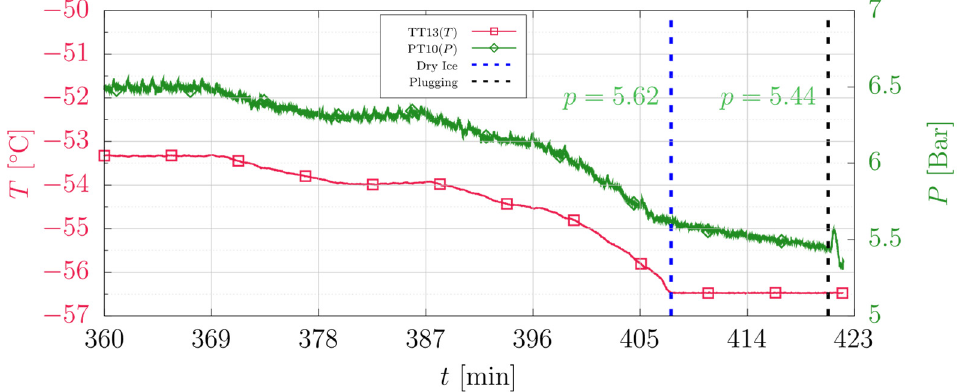
Figure 11. The liquid temperature and the pressure in SV02 during 5 h of stable operation in Experiment 6.